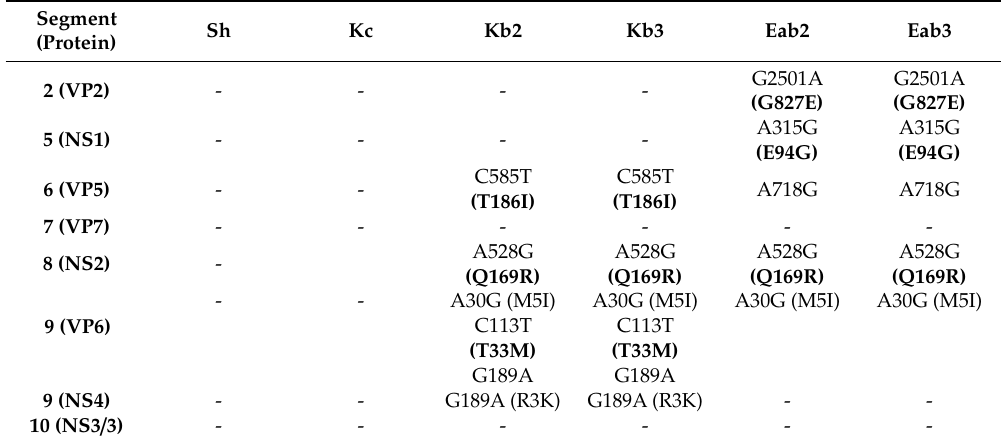
Non-synonymous mutations are indicated in brackets and non-conservative mutations are emphasized in bold font. VP = viral protein; NS = non-structural protein; Kc = Culicoides -derived; Kb = KC / baby hamster kidney cells